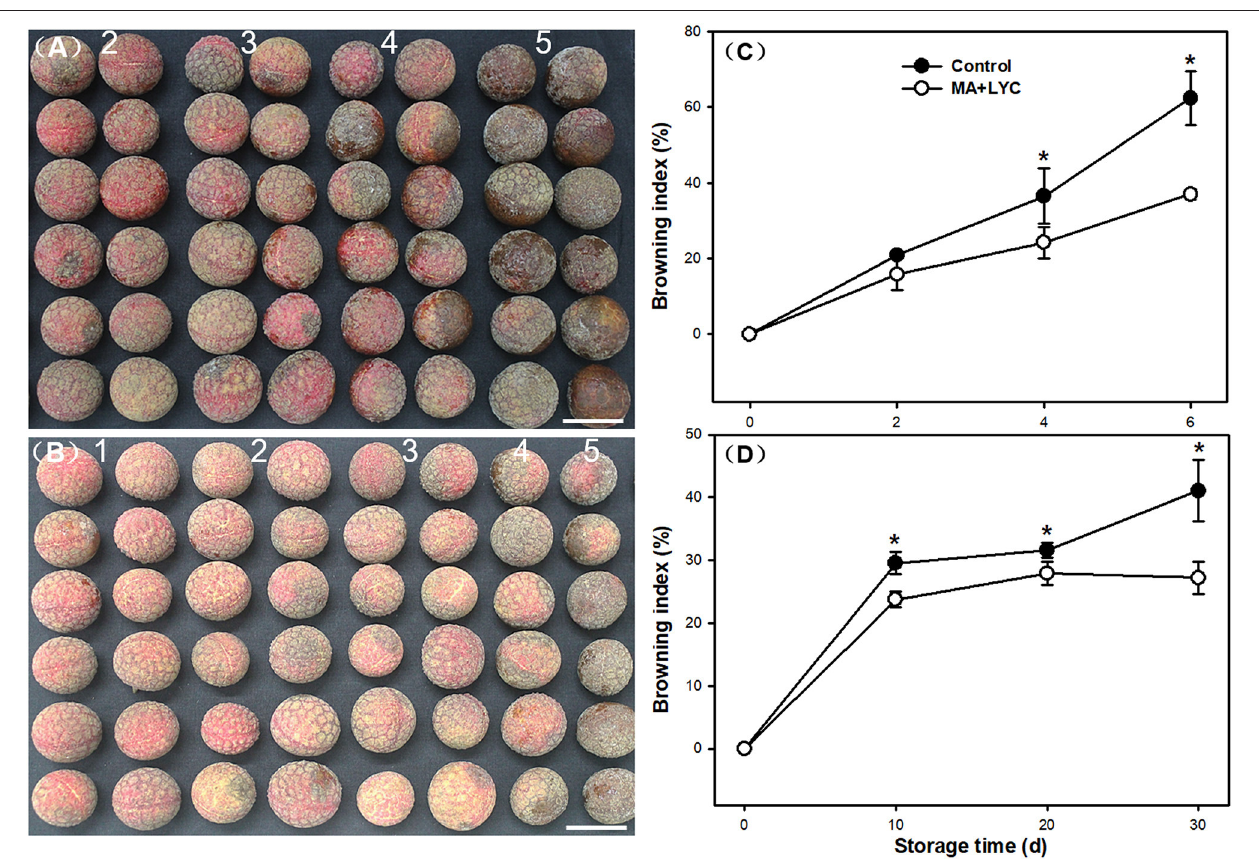
FIGURE 1 | Appearance and the browning index changes in litchi fruit during storage. Appearance differences in litchi fruit taking samples at 6d stored at ambient atmosphere for samples in (A) control, and (B) MA and LYC treatments. Changes in browning index in litchi fruit stored under (C) room and (D) low temperature during storage. Numbers in graph (A) and (B) indicate the browning scale. Scale bars in (A) and (B) indicate 2 cm. Asterisks in (C) and (D) indicate the significant difference of means at 0.05